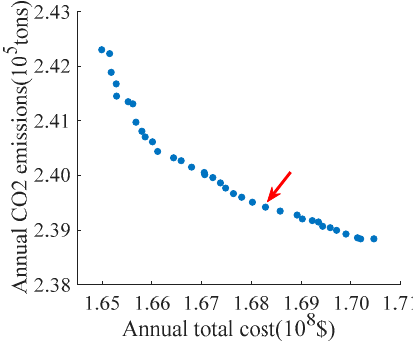
Figure 11. Results from Method 3 under maximum reference load. Table 4. Equipment components of energy system and the capital cost.